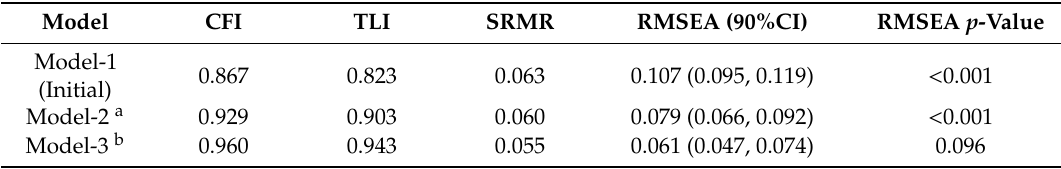
Table 1. Model fit indices for three decisional balance (DB) models.